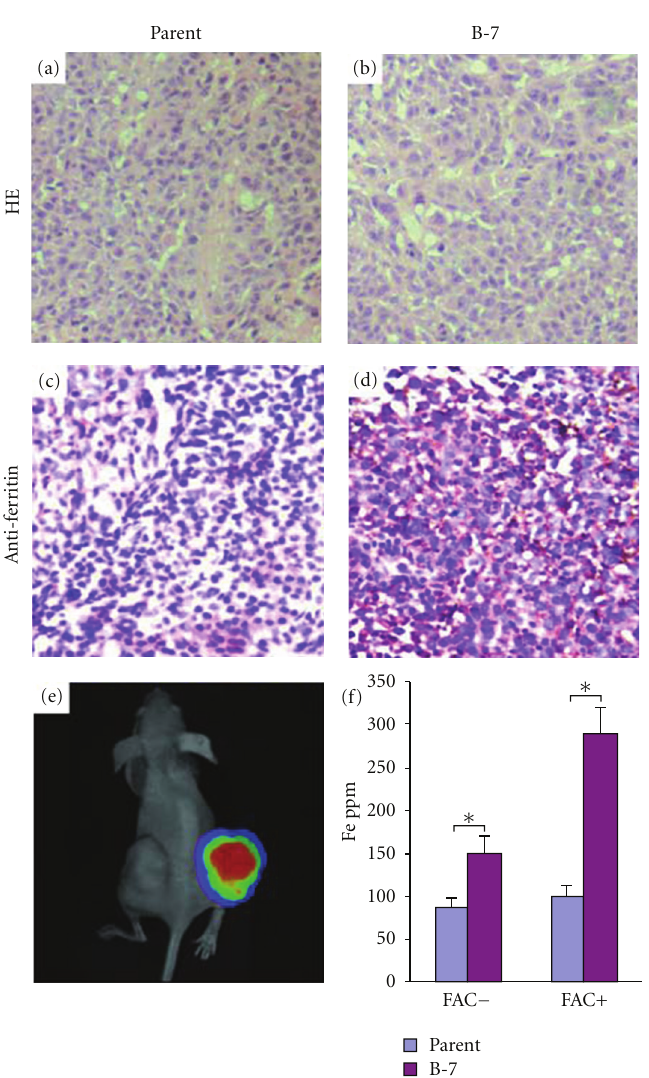
Figure 7: Parent cells (a and c) and B-7 cells (b and d) were inoculated into the hind flank of nude mice (left, parent cells; right, B-7 cells) with (FAC+) or without (FAC − ) FAC supplementation in the drinking water. The tumors were collected for histological examination at the end of 3 weeks. (a and b) HE staining showed overexpression of FTH1 did not cause obvious pathological changes. (c and d) Immunohistochemistry demonstrated overexpression of FTH1 was easily detected in B-7-cell-induced tumors but not in parent-cell-induced tumors. (e) Luciferase activity detected by using bioluminescence imaging technology in vivo . Luciferase activity in B-7 cell induced tumors was increased up to 10 6 photons/sec, but that was not significantly changed in the parent-cell-induced tumors as compared to the background activity ( < 300 photons/sec). Representative image from mice in the presence of FAC. (f) ICP-MS analysis of Fe content measured in parts per million (ppm) dry weight of parent cells or B-7 cell induced tumors. Data were expressed as mean ± SD from 6 experiments. ( ∗ P < 0 .